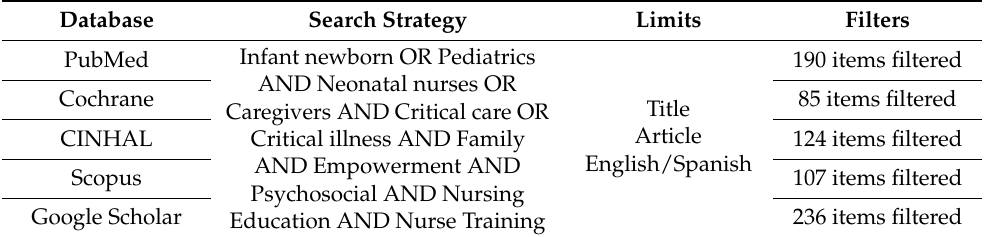
Table 1. Search strategy in databases.